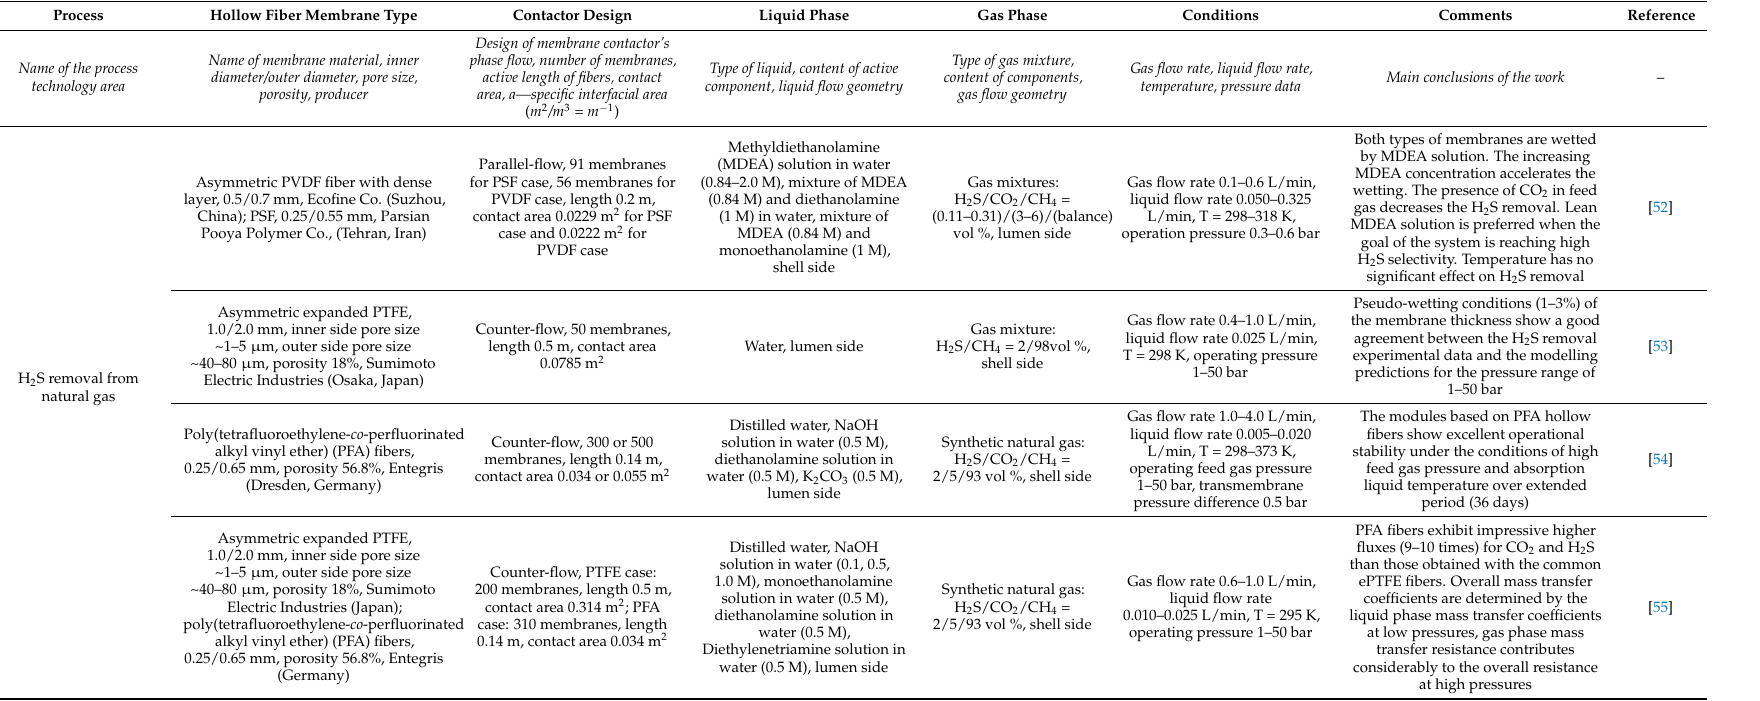
Table 2. Studies of hydrogen sulfide